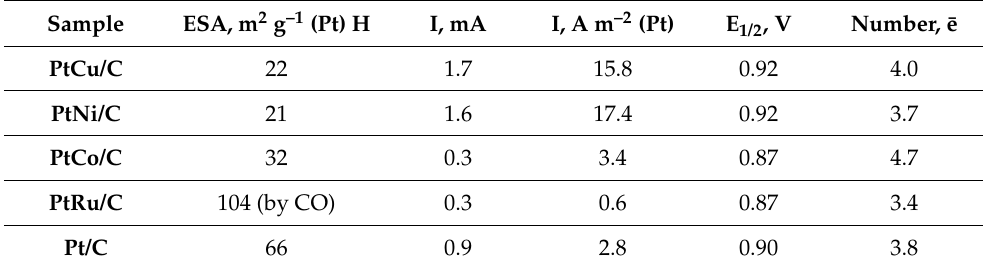
Table 2. The electrochemical characteristics of the bimetallic catalysts after the AST.